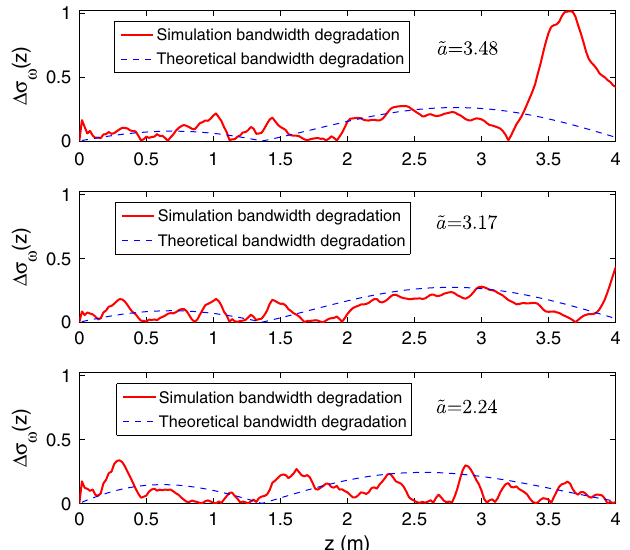
FIG. 5. (Color) Bandwidth degradation for different ~ a . The initial beam energy modulation is (cid:13) 0 : 011 (cid:5) ! 0 . The simulation parameters are listed in Table I, except ~ a and the initial peak current I peak ¼ 1400 , 800, and 100 A for top, middle, and bottom pictures, respectively.